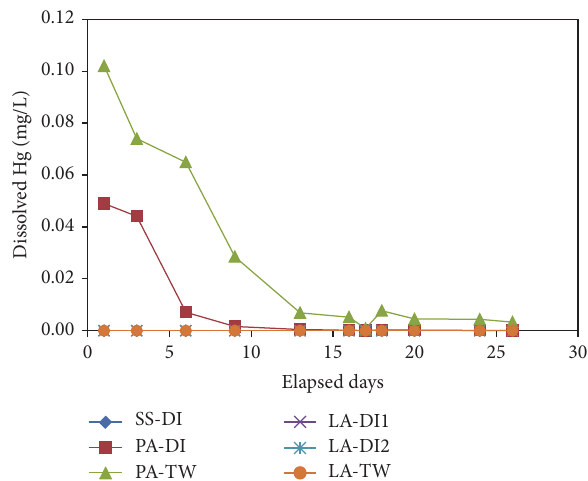
Figure 3: Dissolved Hg concentrations measured over time for each